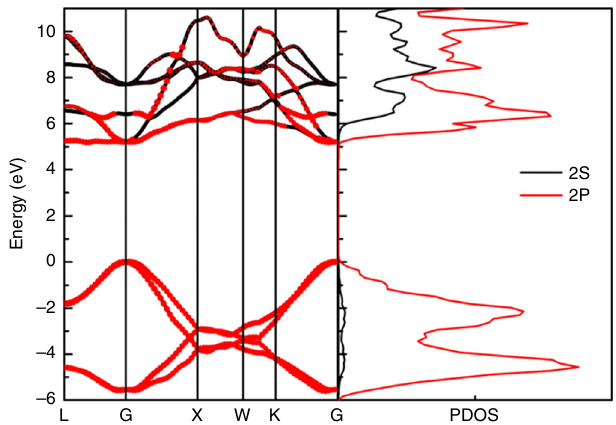
Fig. 3 G 0 W 0 corrected band structure and projected density of states of